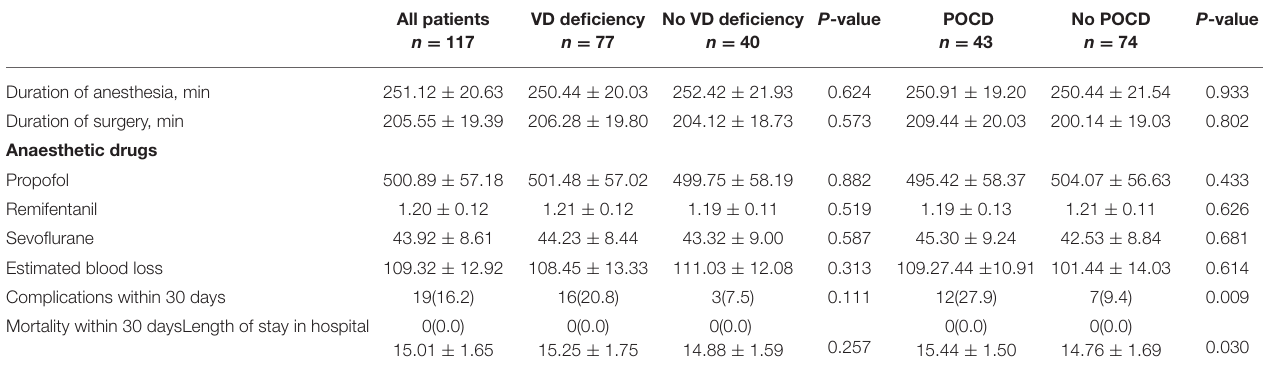
TABLE 3 | Perioperative